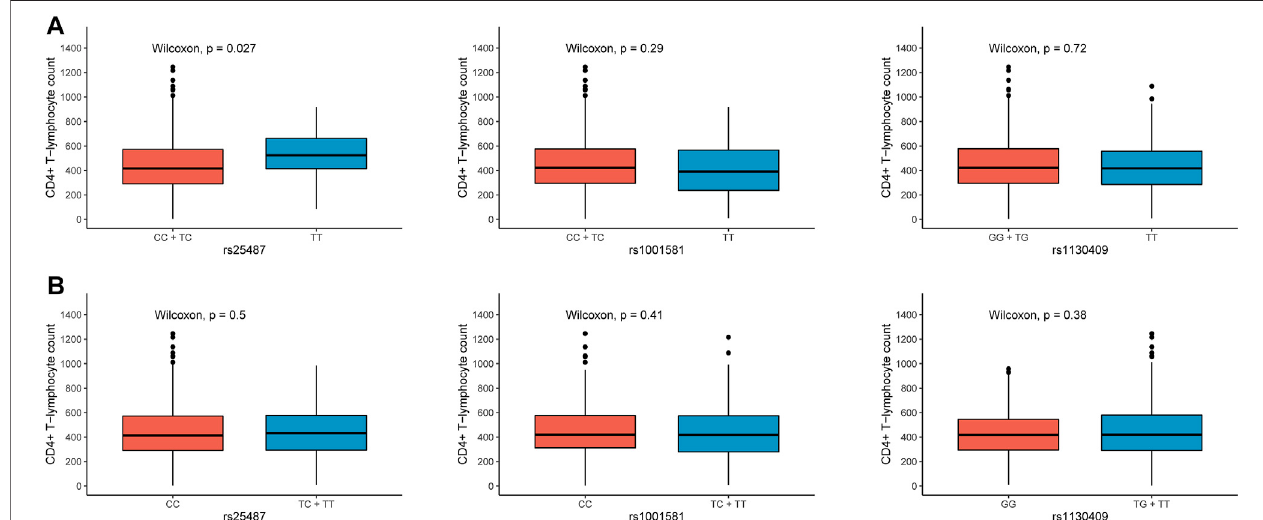
FIGURE 2 | Differential analysis of CD4 + T-lymphocyte count in the different genetic models of rs25487, rs1001581 and rs1130409. (A) Dominant model, (B) Recessive model.